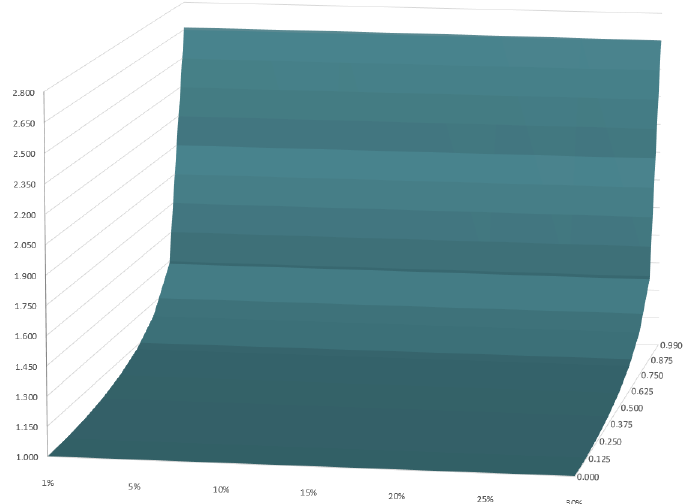
Put t / Put (cid:48) z axis, for t (or t ), displayed on the